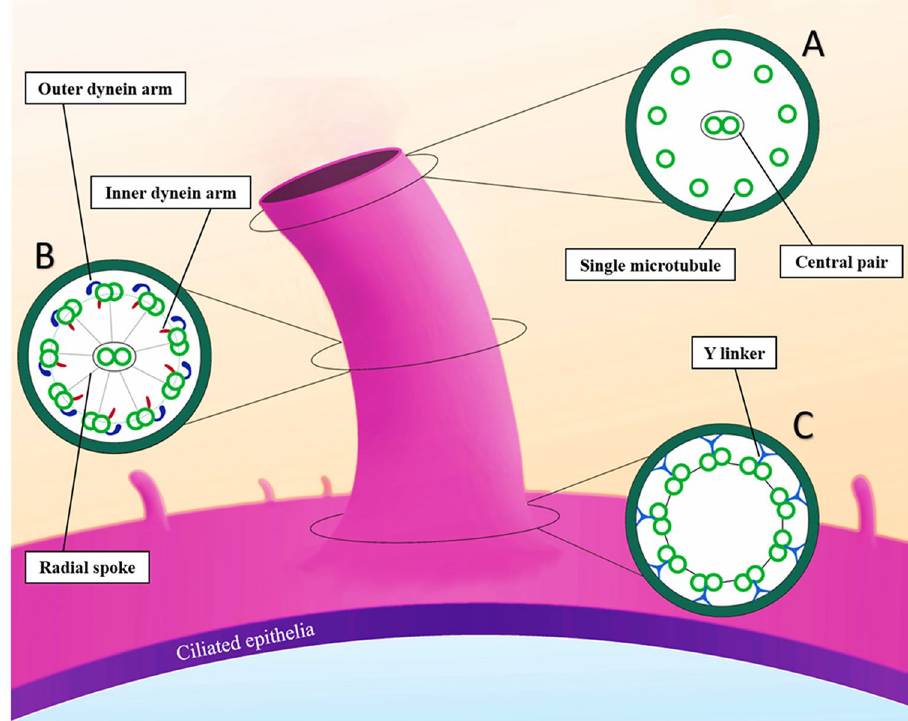
Figure 1. Normal ciliary ultrastructure. ( A ) Tip: cross-sections from the tip of the cilium which consists of single microtubules. It should not be considered a defect. ( B ) Axoneme: it consists of a central pair of microtubules surrounded by nine peripheral microtubule doublets bond to the center pair by supporting radial spokes (known as the 9 + 2 arrangement) Each doublet possesses outer and inner dynein arms. ( C ) Base: cross-section at the base of the cilium, where the central pair is not present. Y-shaped linkers bond microtubule doublets together.